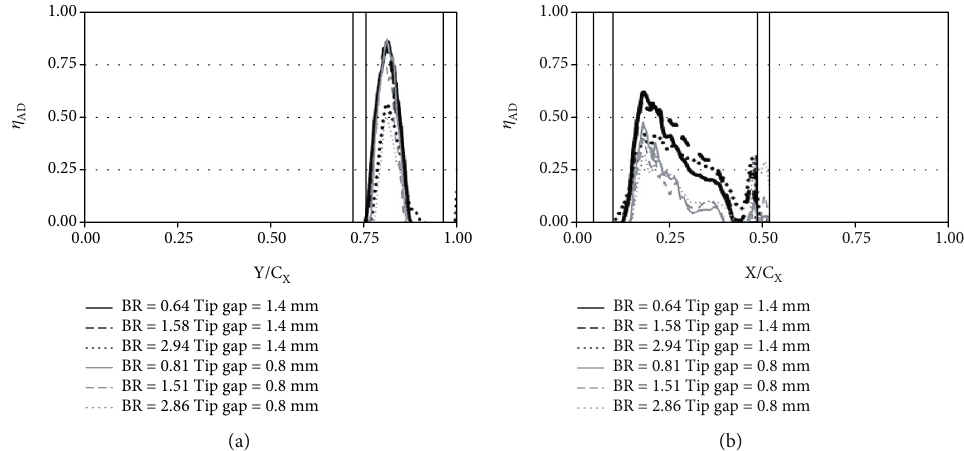
Figure 7: Local adiabatic fi lm cooling e ff ectiveness distributions for the A1 blade for di ff erent tip gaps and blowing ratios. (a) Along line A. (b) Along line B.